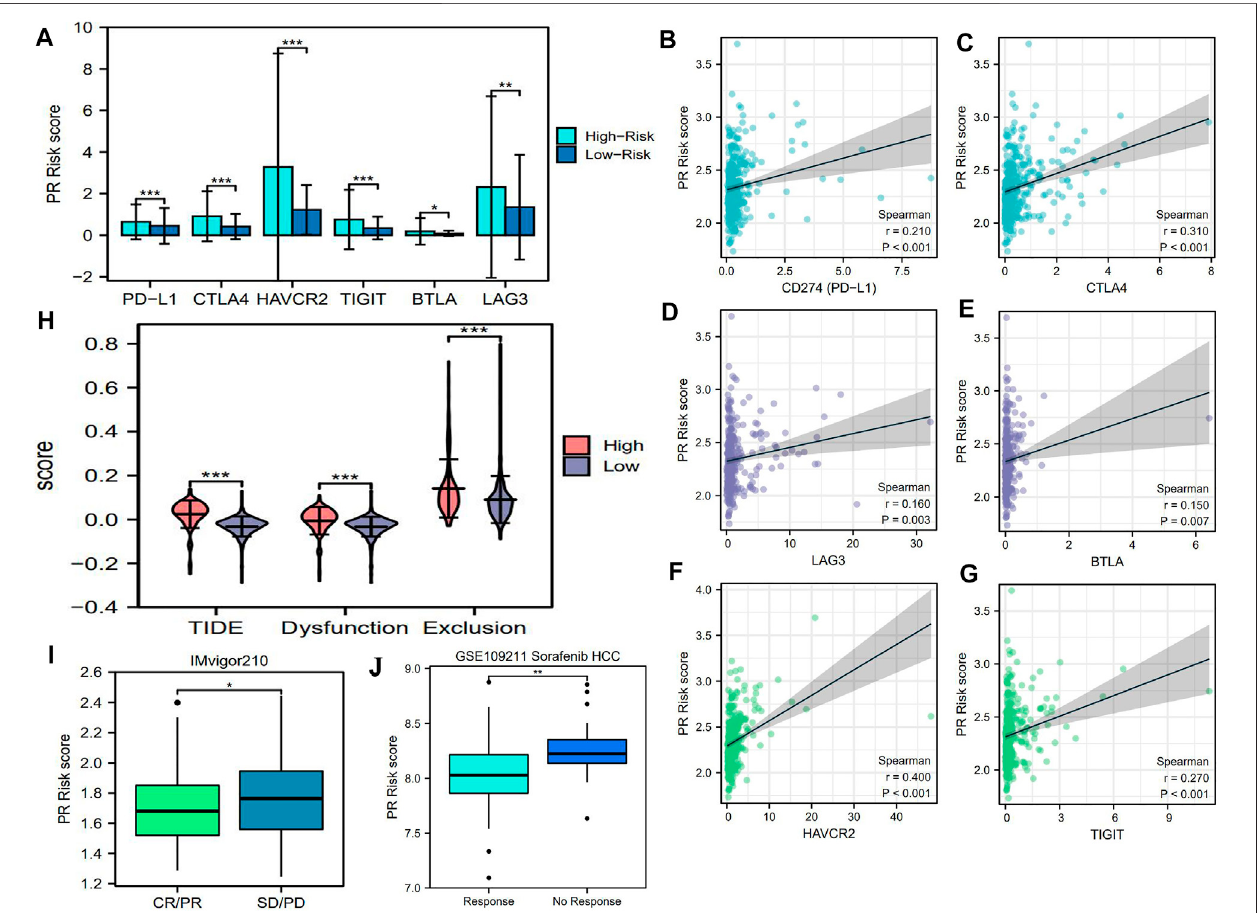
FIGURE 6 | PR risk score implies the ef fi cacy of PD-1/L1 inhibitors and sorafenib. (A) The expression differences of six pivotal ICs between high- and low-PR risk. (B – G) The correlations between PR risk score and the expressions of six ICs. (I) The differences in PR risk score between therapeutic response and non-response patients in IMvigor 210 cohort. (J) The differences in PR risk score between sorafenib response and non-response patients in GSE109211 cohort. PR, pyroptosis- related; PD-1/L1, programmed death 1/ligand 1; ICs, immune checkpoints; * p < 0.05, ** p < 0.01, *** p < 0.001.